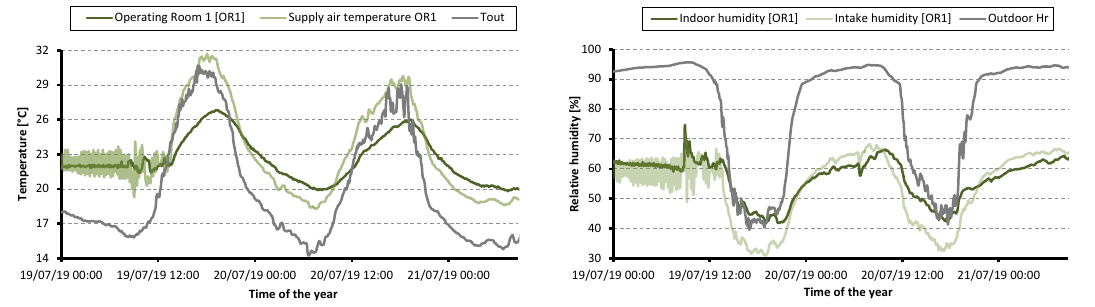
Figure 4. Temperature and RH from OR1 during the first experimental data campaign.